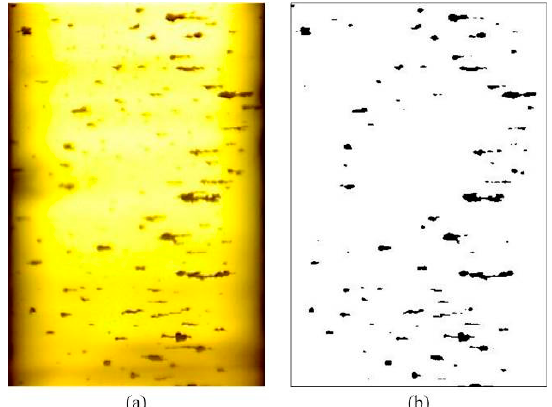
Figure 5. Results after removing low-frequency UDCT coefficients from a ferrogram with small wear debris. ( a ) on-line visual ferrograph (OLVF) ferrogram; ( b ) removing low-frequency coefficients after UDCT decomposition.